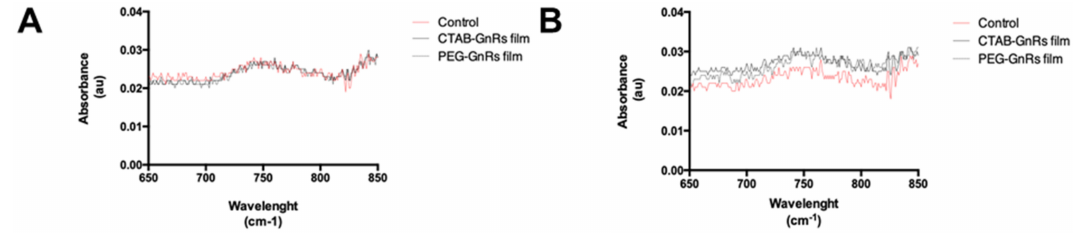
Figure 10. Absorbance of PBS after polymeric films were immersed for 5 min ( A ) and 1 h ( B